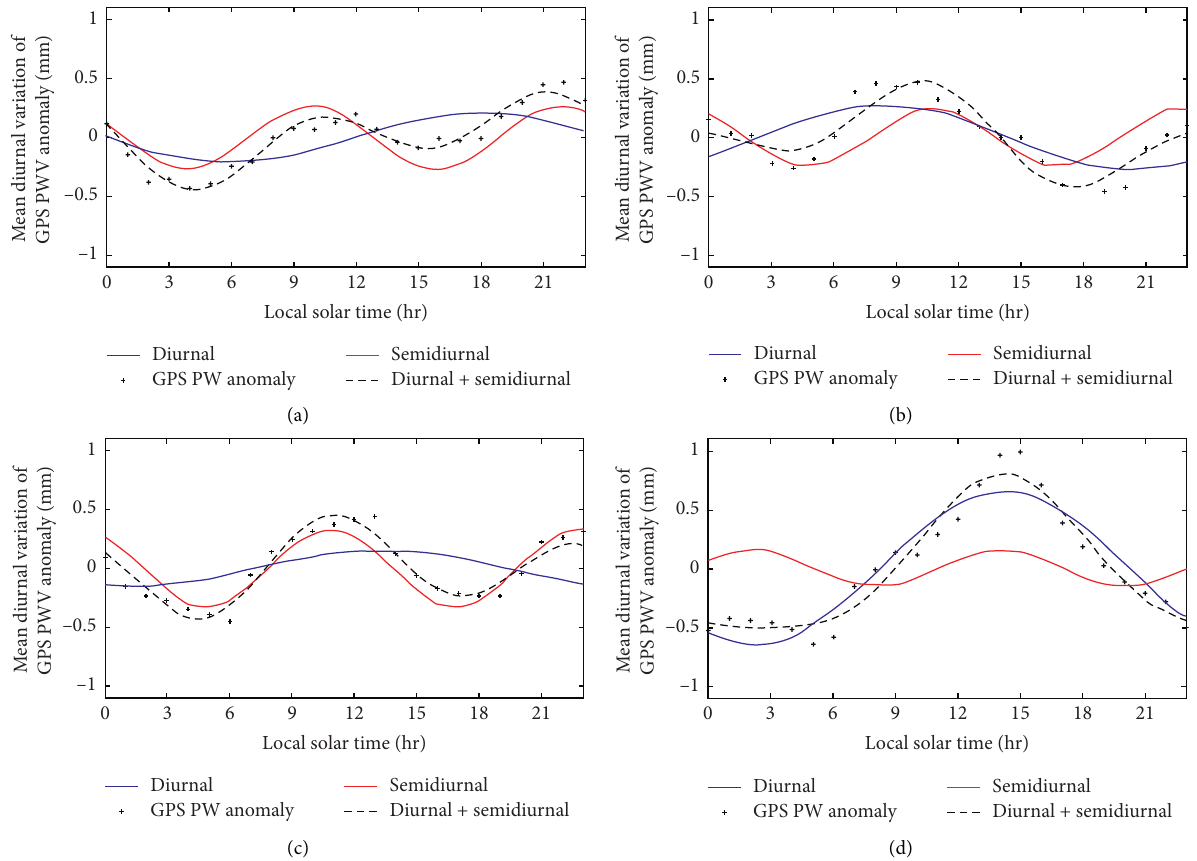
Figure 7: Mean July-August diurnal variations of GPS PWV anomaly (mm) and the fitted diurnal and semidiurnal harmonics at (a) Poyang, (b) Duchang, (c) Nanchang, and (d) Fengxin stations. Dashed curves are the sum of the fitted diurnal and semidiurnal